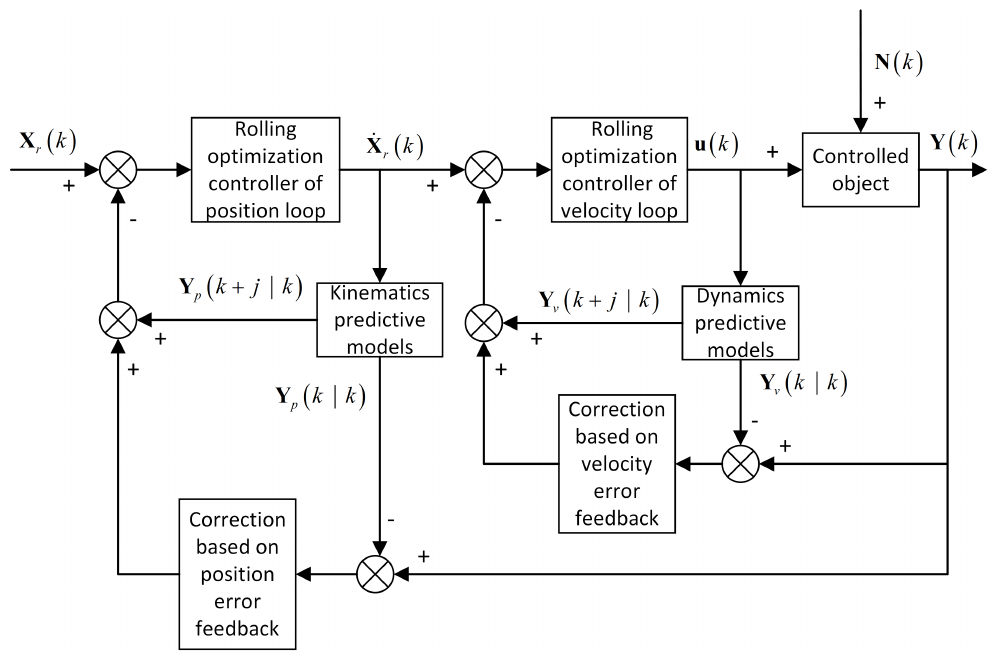
Figure 7. Schematic diagram of the dual-loop